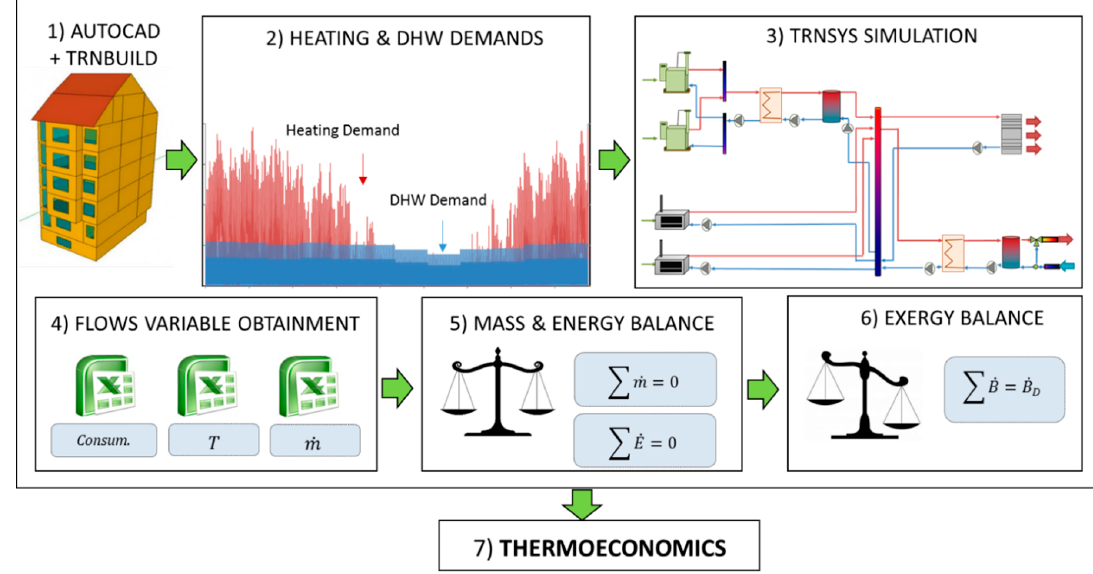
Figure 6. Schematic modelling of the heating and DHW installation.